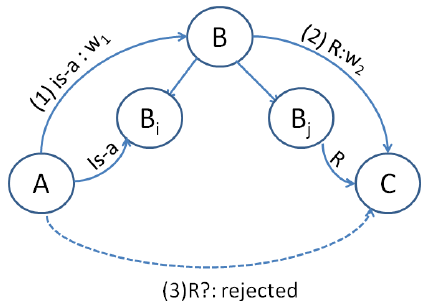
Triangular inference scheme with logical blocking based on the polysemy of